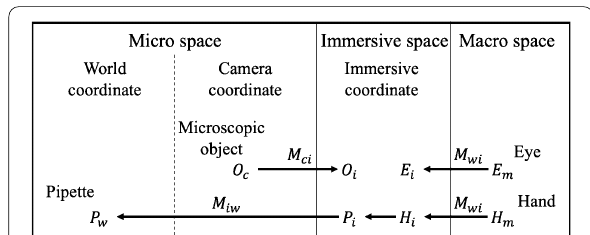
Fig. 10 Mapped model of micromanipulators operation